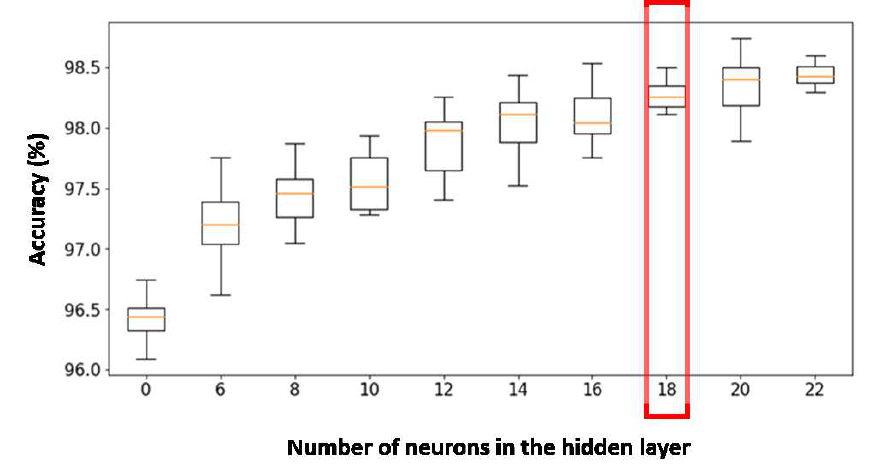
Figure 9. Accuracy obtained for every stroke classifier architecture with 10 cross